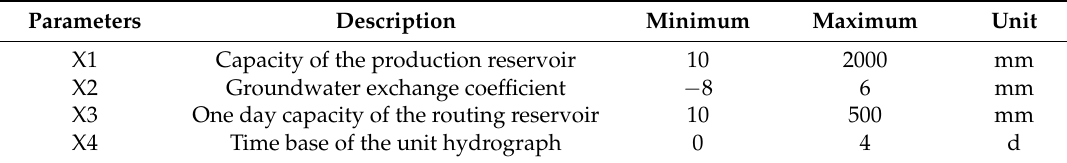
Table 1. Ranges of parameters of the GR4J